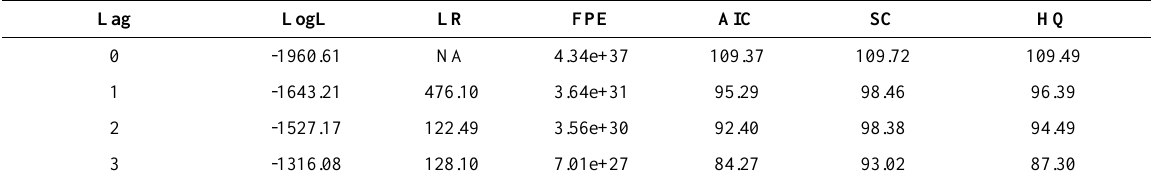
Table 7. Lag order selection criteria.